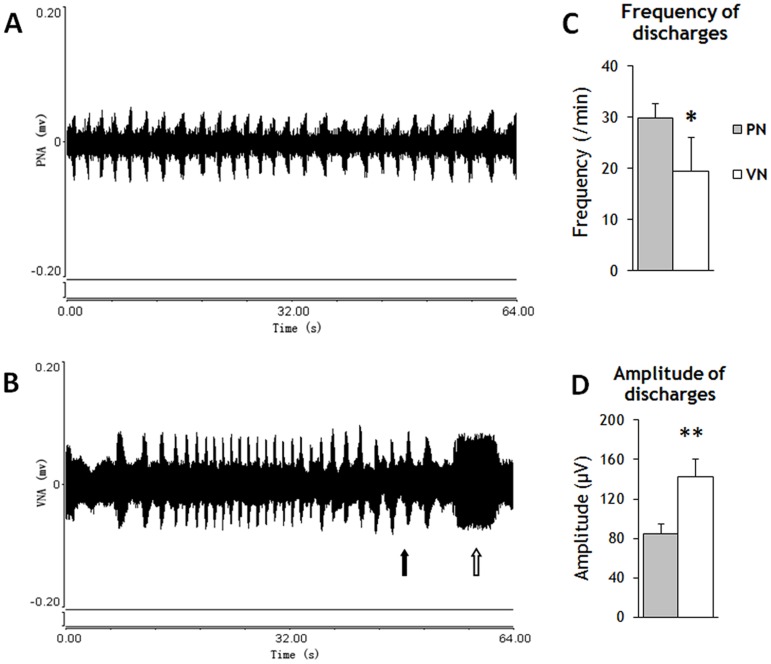
Spontaneous efferent discharges from the PN and VN.
A. Rhythmic discharges from the PN. B. Sporadic, variable frequency discharges from the VN. The frequency was sometimes close to that of the PN (solid arrow). Prolonged discharges (open arrow) were only recorded from the VN. C. Mean discharge frequencies from the PN and VN (p = 0.021). D. Discharge amplitudes of PN and VN (P<0.001). The error bars indicate standard deviation (SD). * p<0.05; ** p<0.001